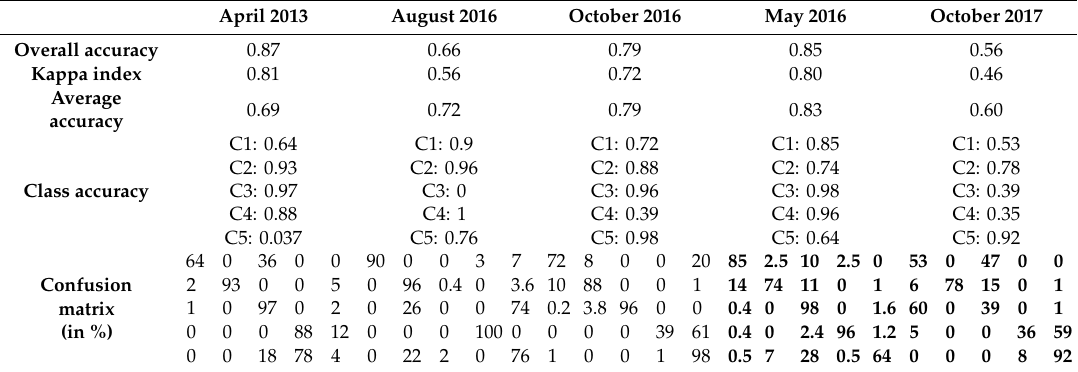
Table 3. Accuracy metrics from the supervised Random Forests classification on the five dates of 3-band (G, R and NIR) multi-spectral Pl é iades images. Class assignment: C1— Spartina anglica , C2— Spartina maritima , C3—slikke vegetation dominated by Zostera, C4—mudflat, and C5—biological deposits (algae /